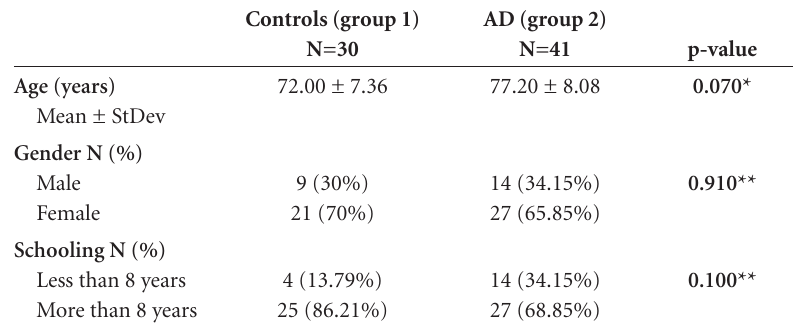
Table 1. Features of 71 patients grouped according to diagnosis.